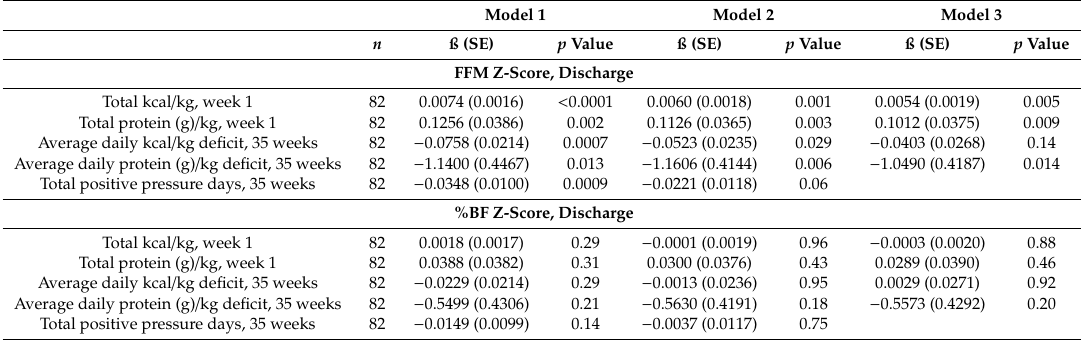
Table 2. Associations between Nutrient intake, Early and chronic illness and Body composition z-scores at Hospital Discharge among VLBW preterm infants.